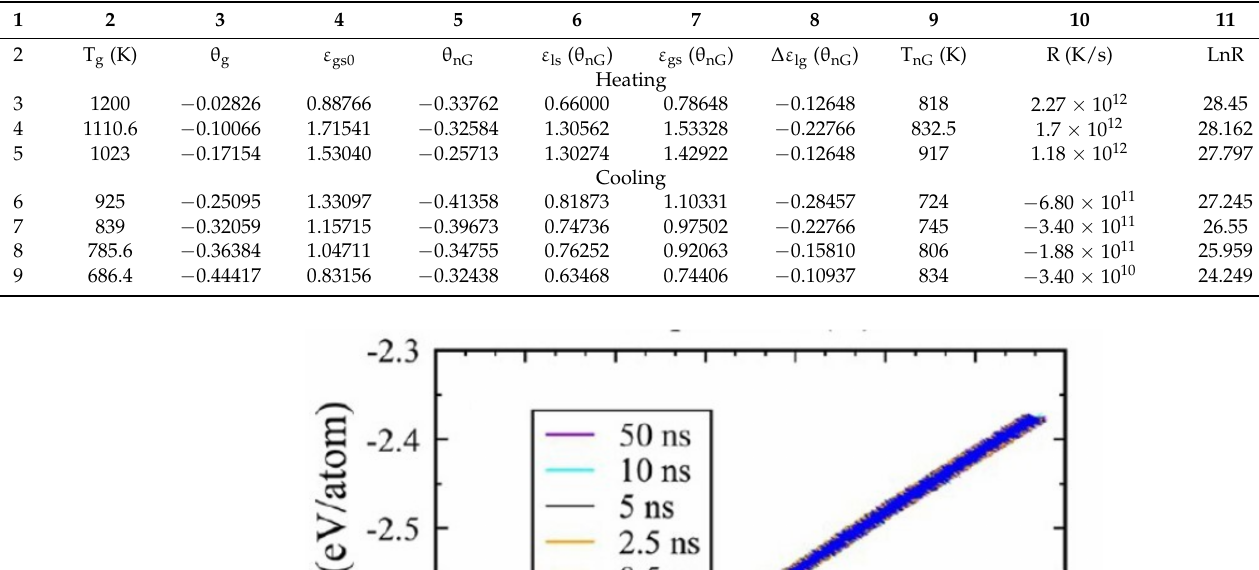
Table 3. Nucleation temperatures T nG of Ag glacial phases below T m . T g and θ g for various values of heating and cooling rates R in K/s; ε gs0 deduced from Equation (8) with ∆ ε = 0; θ nG the reduced nucleation temperature of glacial phase leading to singular values ∆ ε lg ( θ nG ) = ε ls ( θ nG ) − ε gs ( θ nG ) = − θ n+ ; ε ls ( θ nG ) and ε gs ( θ nG ) deduced from Equations (4) and (5); temperatures T nG ; R (K/S) and LnR introduced in Equation (10) to determine T g (K).